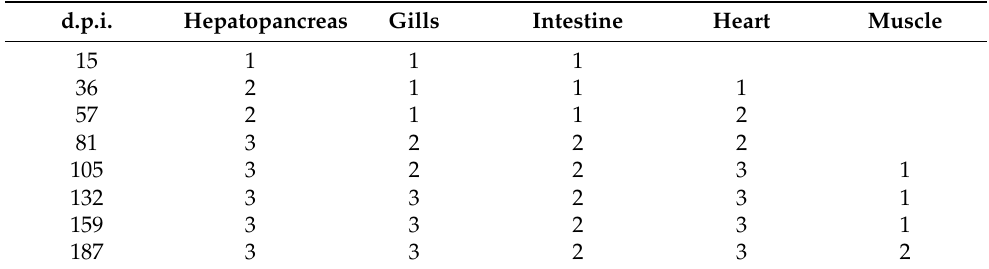
Table 3. Histological evaluation of juveniles of Panulirus argus experimentally infected with